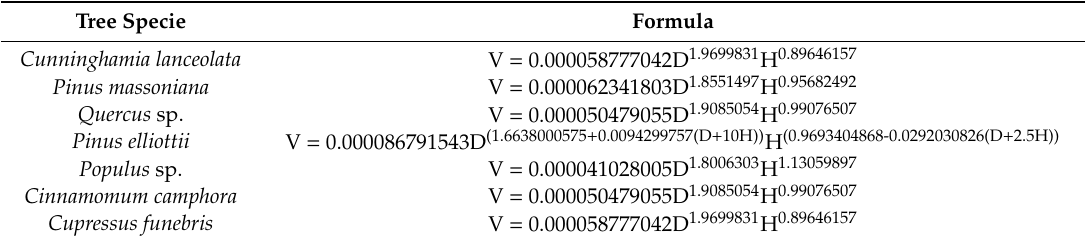
Table 2. The FSV calculation formula of the seven major tree species in Hunan Province